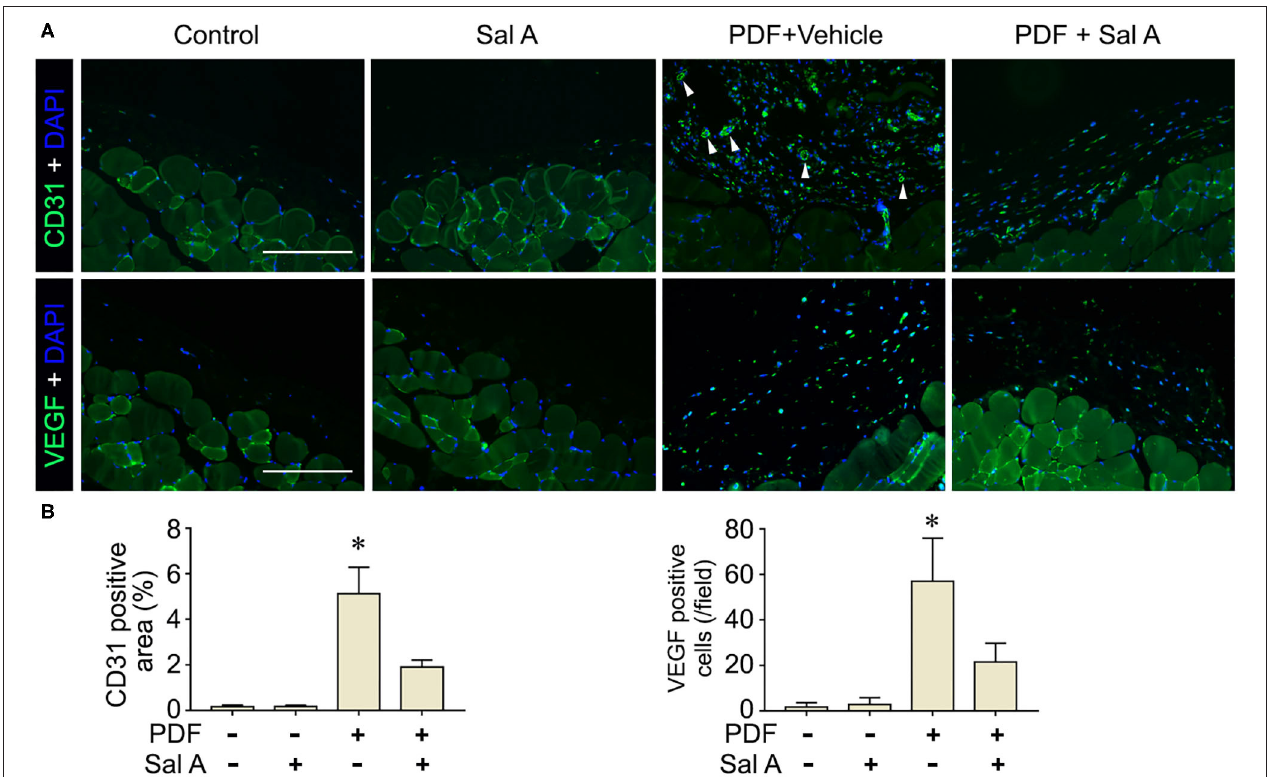
FIGURE 5 | Sal A treatment of murine models of peritoneal dialysis mitigated endothelial proliferation and maladaptive angiogenesis in peritoneum. (A) Mice were treated as elaborated in Figure 2 . The peritoneal tissues were collected on week 7 and subjected to fluorescence immunohistochemistry staining for CD31 and VEGF with nuclear counterstaining of DAPI. The arrowheads indicate CD31 positive vessels. Scale bar = 200 µ m. (B) Quantification analysis of CD31 positive area and VEGF positive cells per microscopic field. Data were analyzed by one-way ANOVA followed by Tukey’s test. * P < 0.05 vs. other groups ( n =